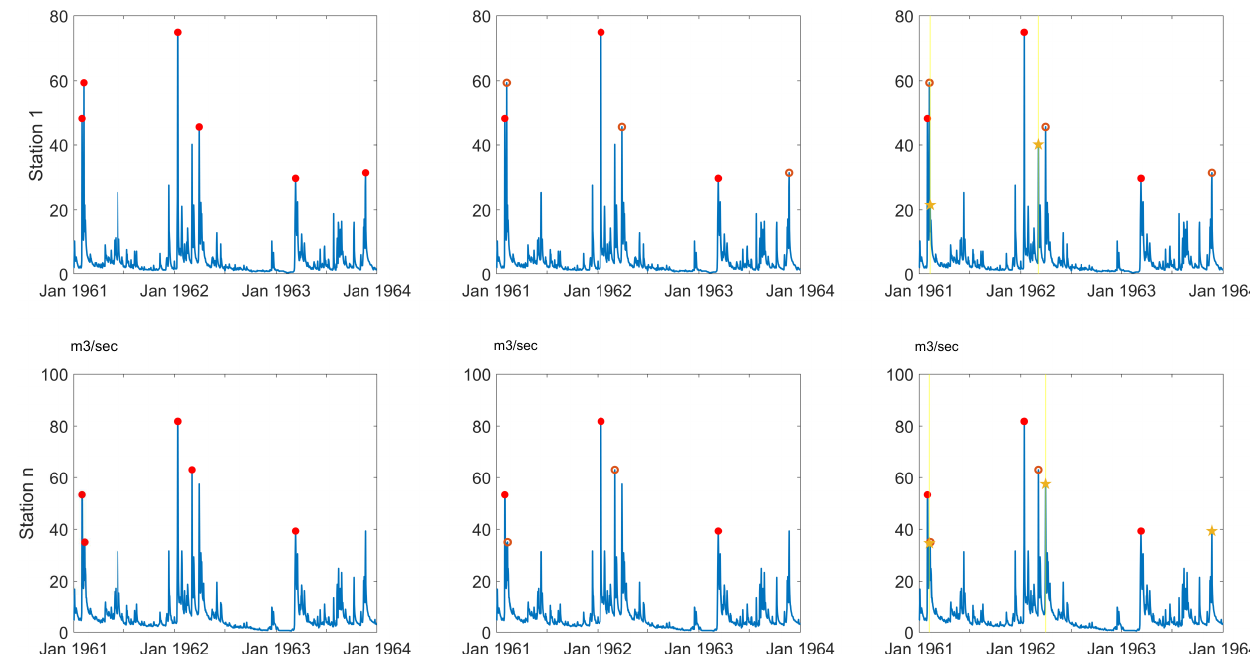
Figure 2. The procedure of flood events identification in discharge time series (m 3 /s); red dots: independent peaks, red circles: individual events, yellow stars: correspond peak in other time series, yellow lines: the bound of selecting correspond